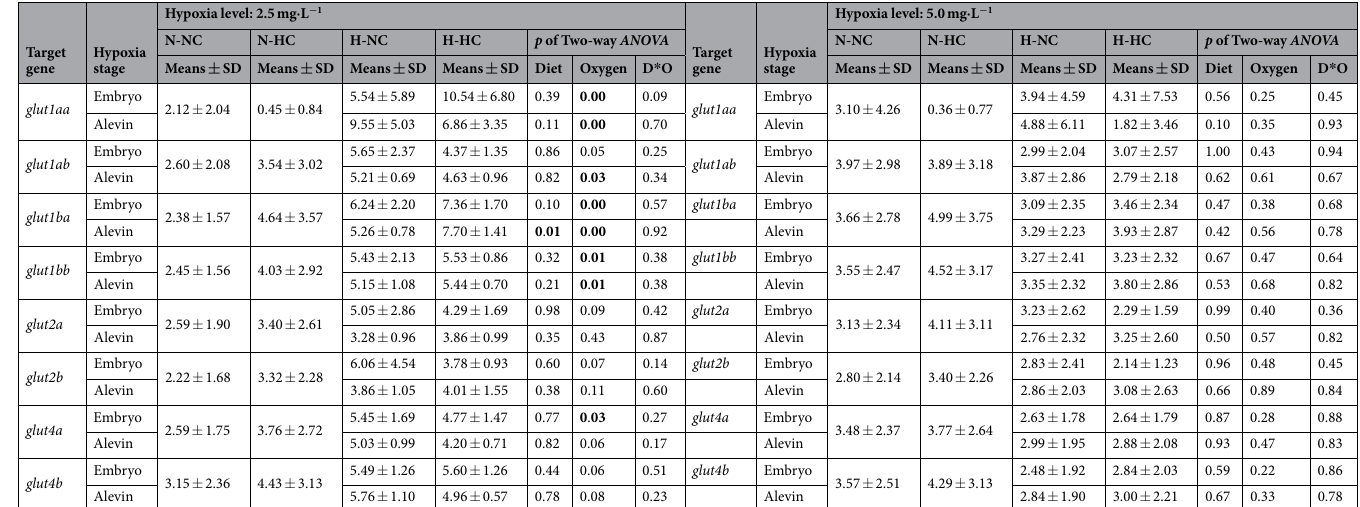
Table 5. Effects of early hypoxia and high-carbohydrate diet at first-feeding on gene expressions involved in glucose transport pathway. N-NC, N-HC, H-NC and H-HC stands for fish subjected to normoxia and no carbohydrate diet, normoxia and high carbohydrate diet, hypoxia and no carbohydrate diet and hypoxia and high carbohydrate diet, respectively. Data were presented as mean ± SD (n = 6), statistical differences were evaluated by two-way ANOVA ( p < 0.05, values in